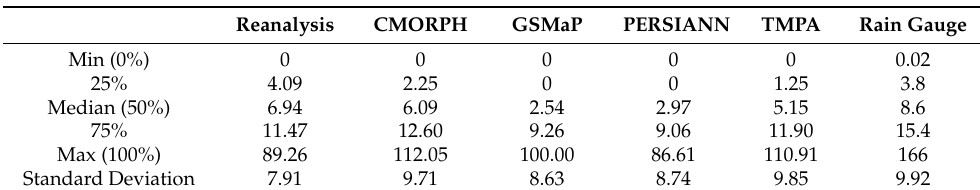
Table 2. Percentiles and standard deviations of rainfall prediction from models as well as the measured rainfall (Target). All units are mm/day.